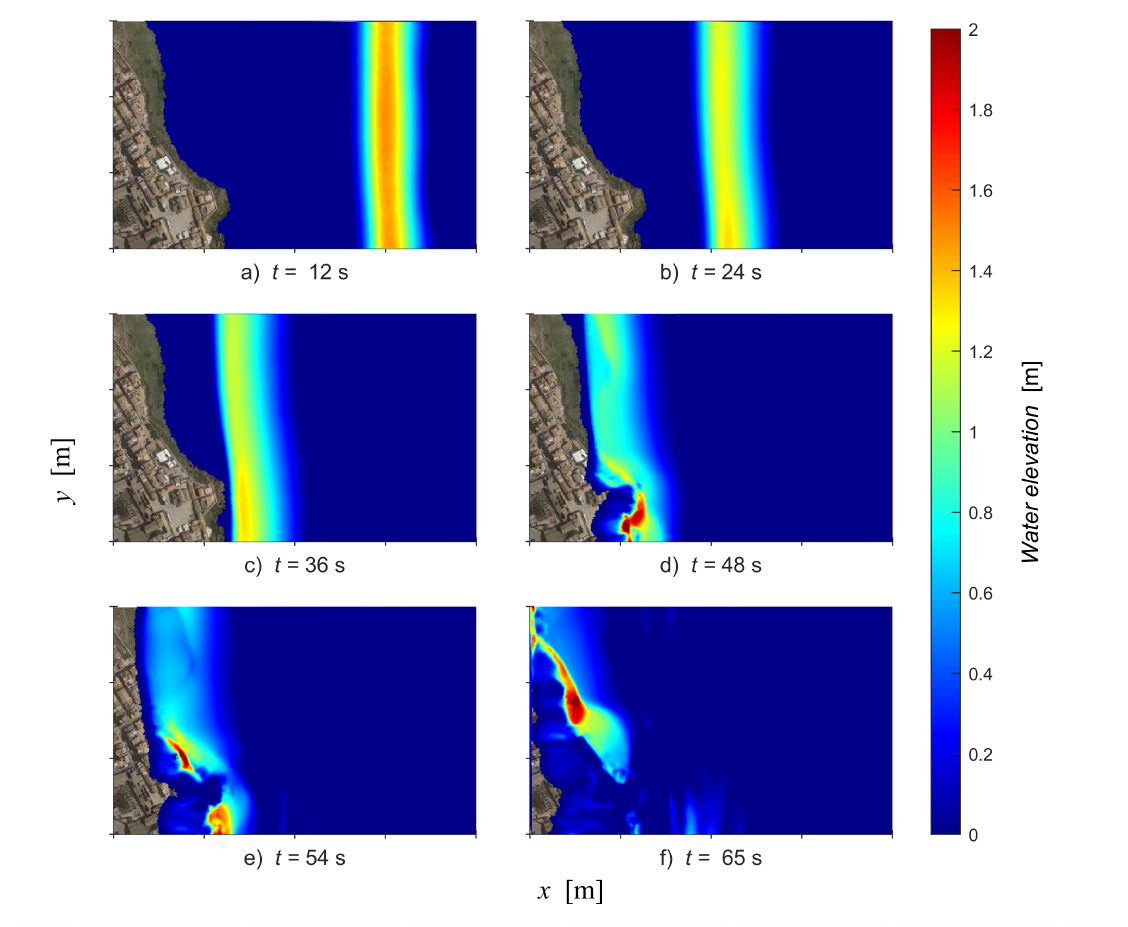
Figure 11. Water surface elevation. The origin of coordinate axis is E = 510,569 m; N = 4,066,207 m; WGS84 UTM33N reference